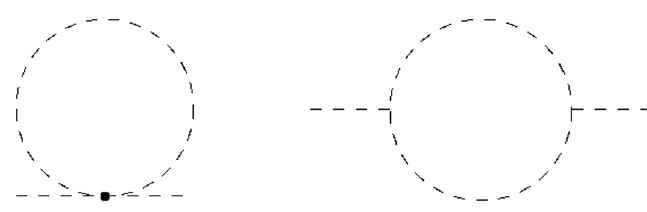
Figure 1 . Example of quantum corrections to the WL scalar mass at one-loop. The fields in the loop are not specified in this